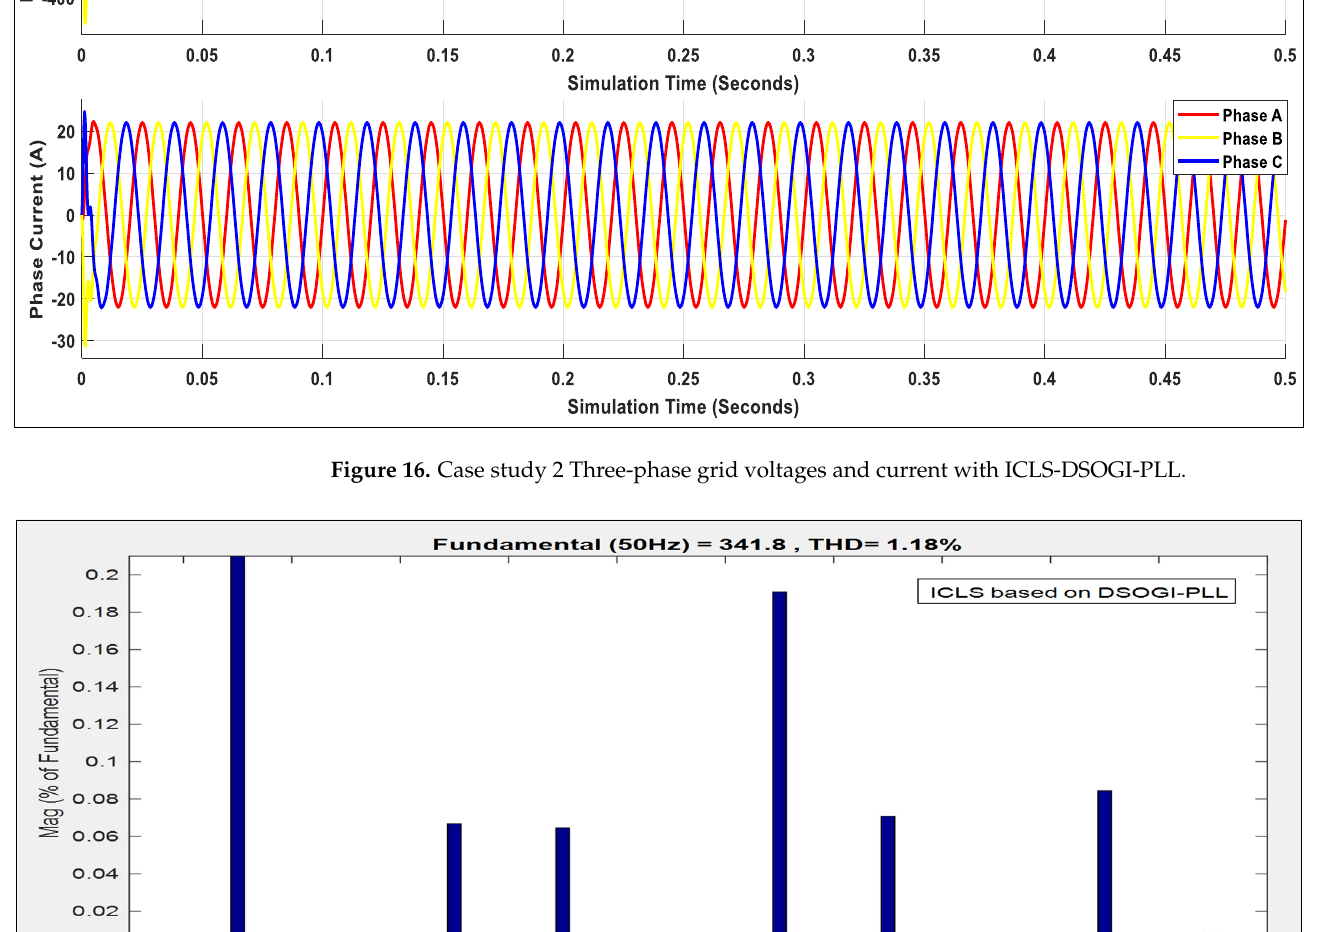
Figure 17. The THD case study 2 performance results with ICLS-DSOGI-PLL.